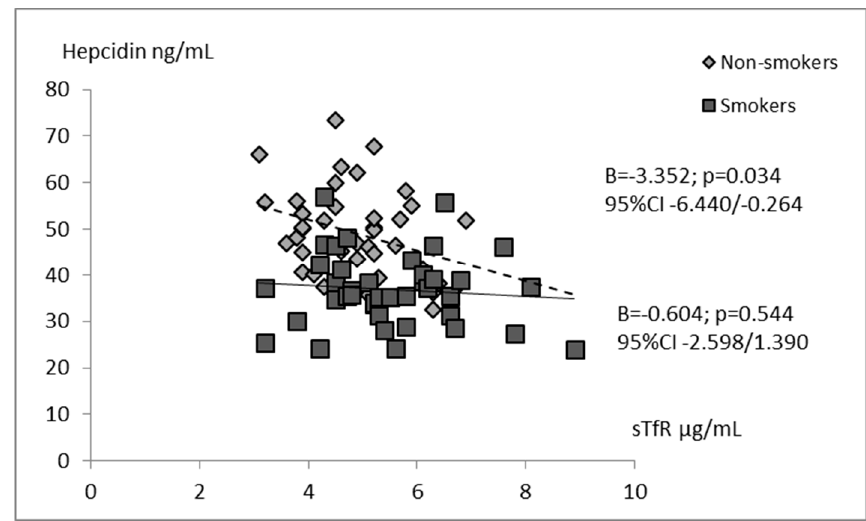
Figure 2. Univariate regression analyses of hepcidin with soluble transferrin receptor in the groups of smoking women’s newborns ( n = 40) and non-smoking women’s newborns ( n = 40). smoking women’s newborns ( n = 40) and non-smoking women’s newborns ( n = 40).